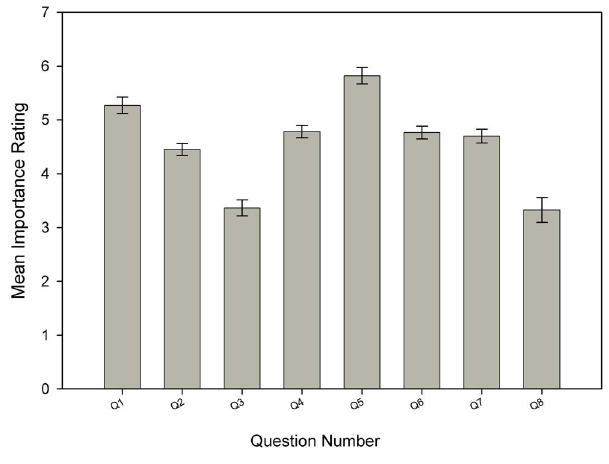
Figure 1. Summary of the most important factors when buying a new aquarium species. Summary of hobbyist responses when asked what the most important factors are when buying a new aquarium. The higher the mean score the greater the perceived importance. 1. It looks good; 2. Price; 3. My local shop recommended it; 4. It’s easy to care for; 5. Compatibility; 6. It provides a function within the aquarium; 7. Collection source (tank bred or wild caught); 8. Other.